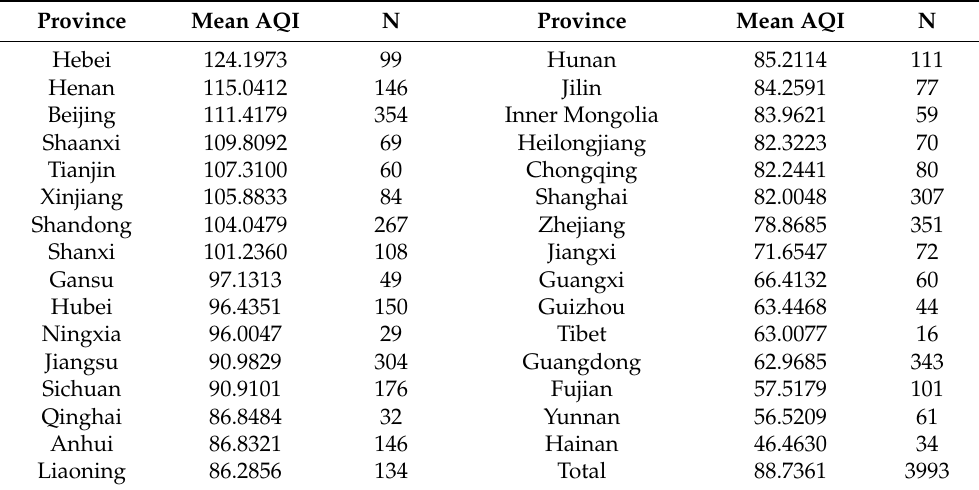
Table 3. Air pollution conditions of the provinces where the sample firms were